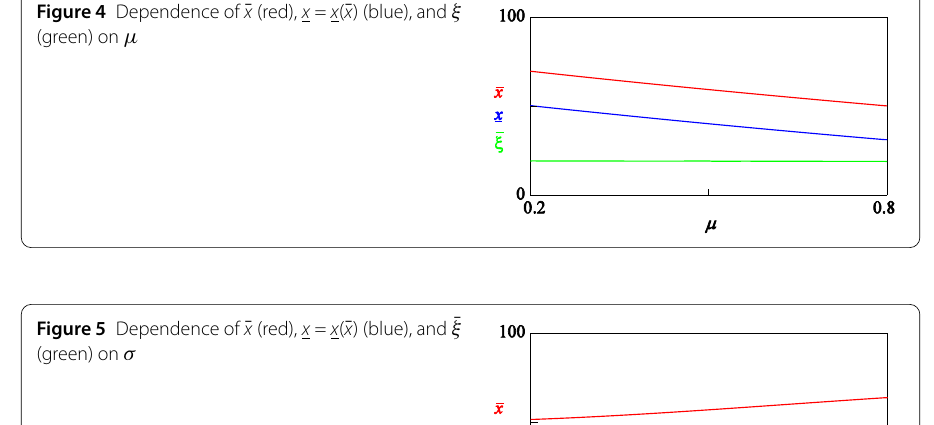
Figure 4 Dependence of ¯ x (red), x = x ( ¯ x ) (blue), and ¯ ξ (green) on μ